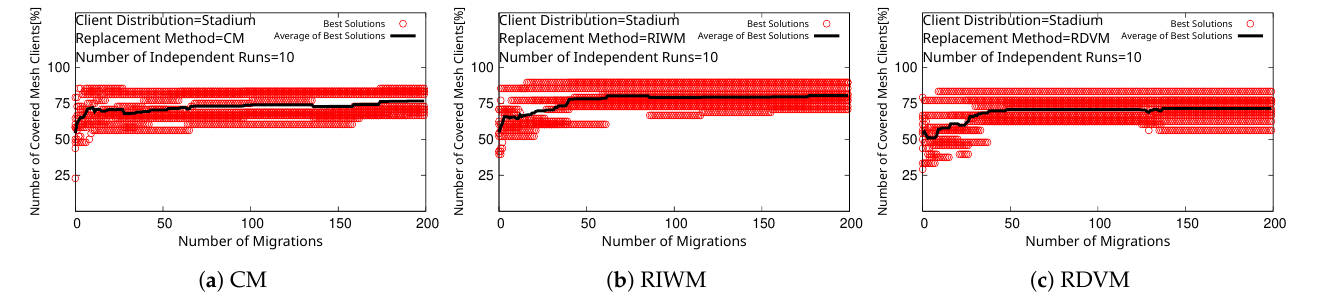
Figure 8. Simulation results of WMN-PSOSA-DGA for NCMC.